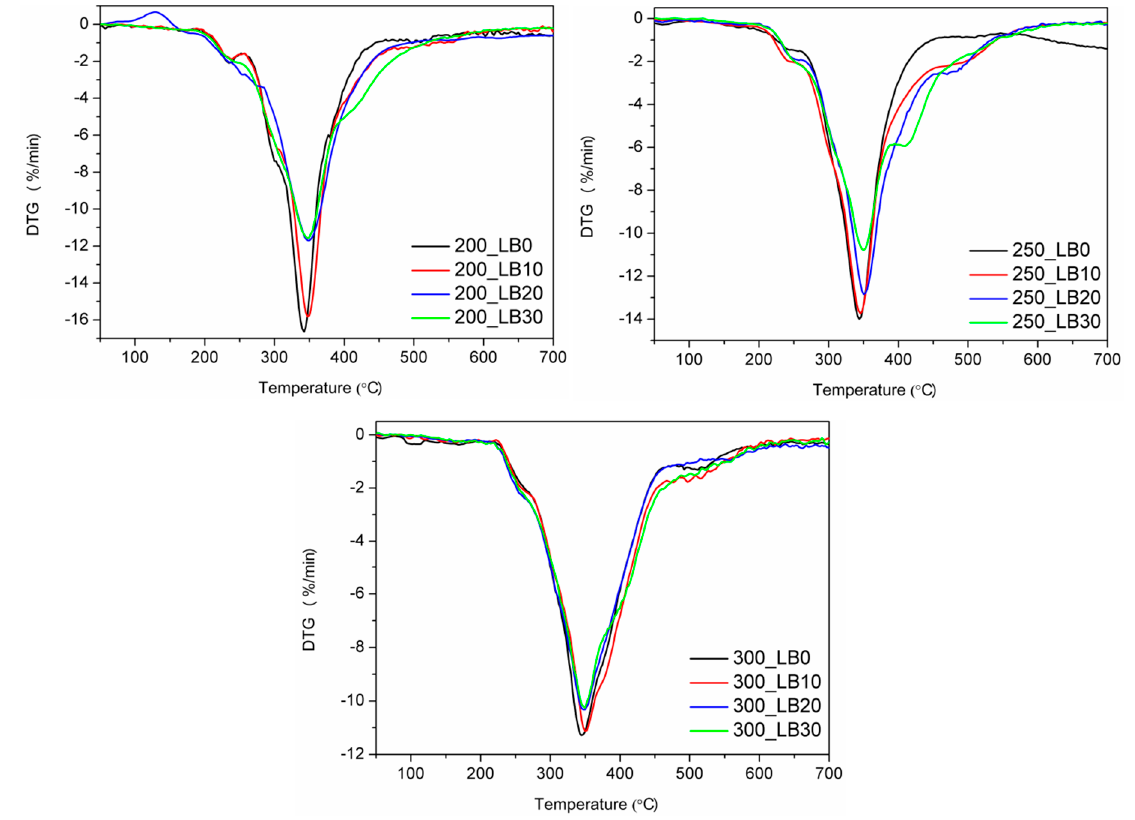
Figure 4. DTG curves of rigid PUR-PIR foams.